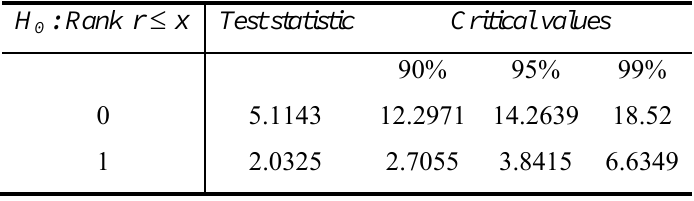
Table 3 Cointegration Tests for DJIA (without consumption